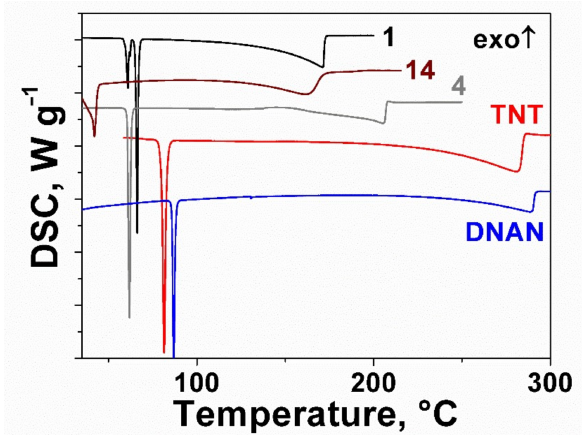
Figure 8. DSC profiles illustrating the melting and subsequent evaporation of selected furoxans 1 , 4 , 14 and the reference energetic materials TNT and 2,4-dinitroanisole (DNAN). The heating rate is 5 K min − 1